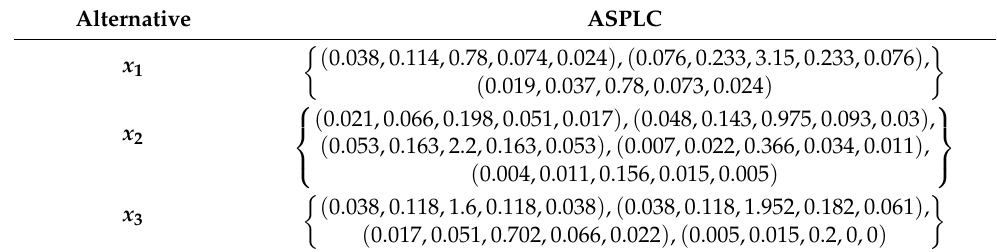
Table 5. Decision evaluation use for ASPLC.